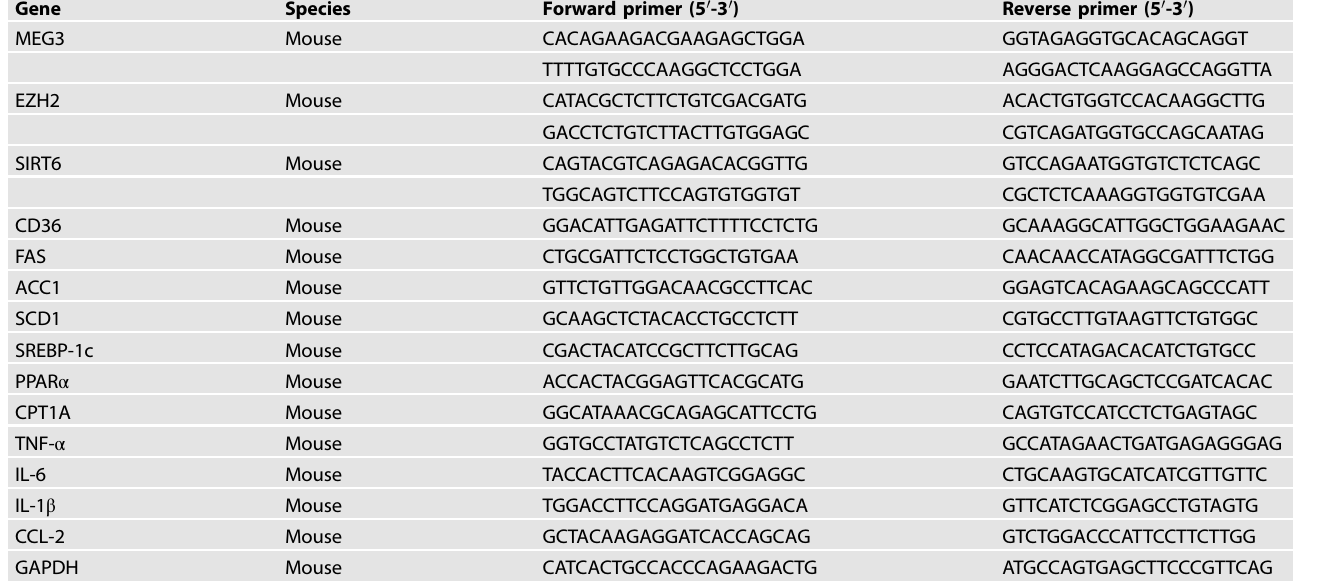
Table 1. Sequences for primers used for RT-qPCR